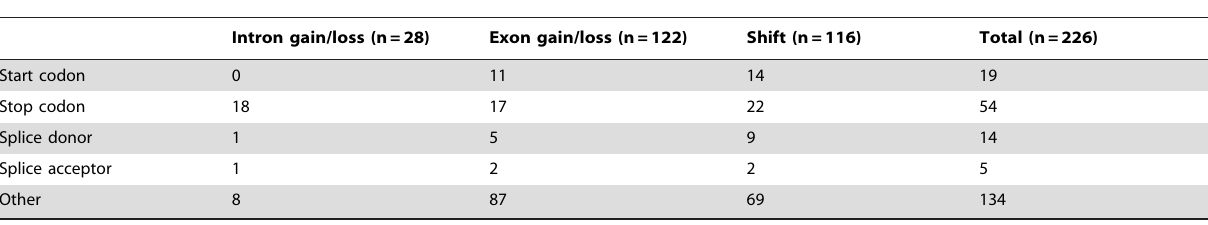
Table 1. Locations of SNPs that perfectly associate with gene